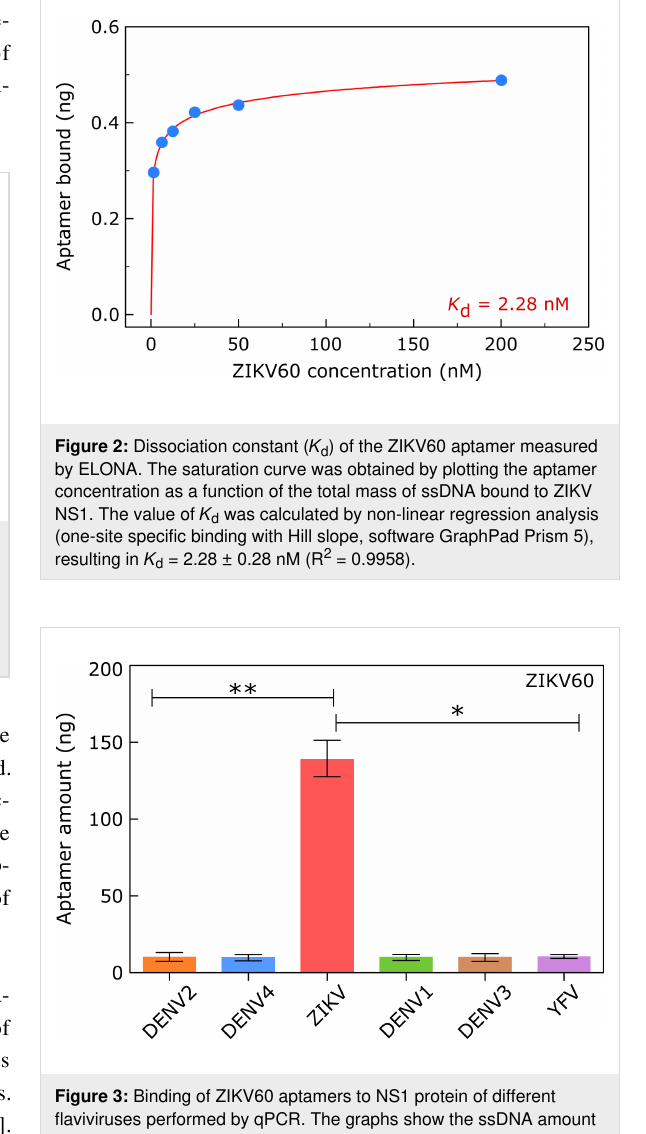
Figure 3: Binding of ZIKV60 aptamers to NS1 protein of different flaviviruses performed by qPCR. The graphs show the ssDNA amount (ng) recovered after incubation of 100 nM of ZIKV60 with NS1 protein (40 pmol) of the different flaviviruses: ZIKV, DENV (serotypes 1, 2, 3, and 4), and YFV. Statistical analyses were performed using the GraphPad Prism 5 software. * p < 0.05 and ** p <